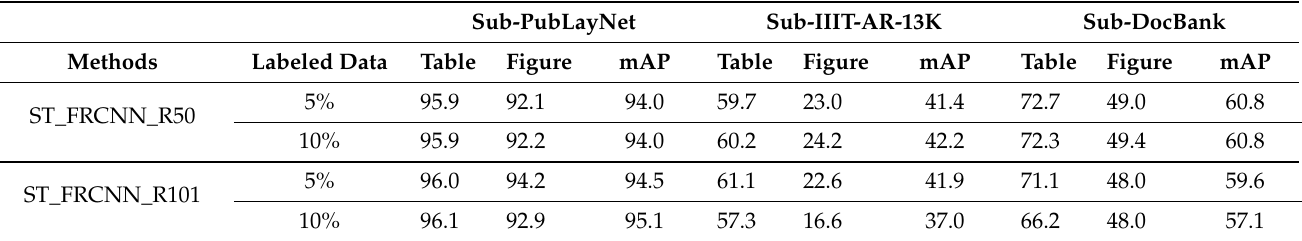
Table 13. The table represents the mAP@(0.5:0.95) of sub-PubLayNet, sub-IIIT-AR-13K and sub- DocBank validation datasets on a sub-PubLayNet trained model.